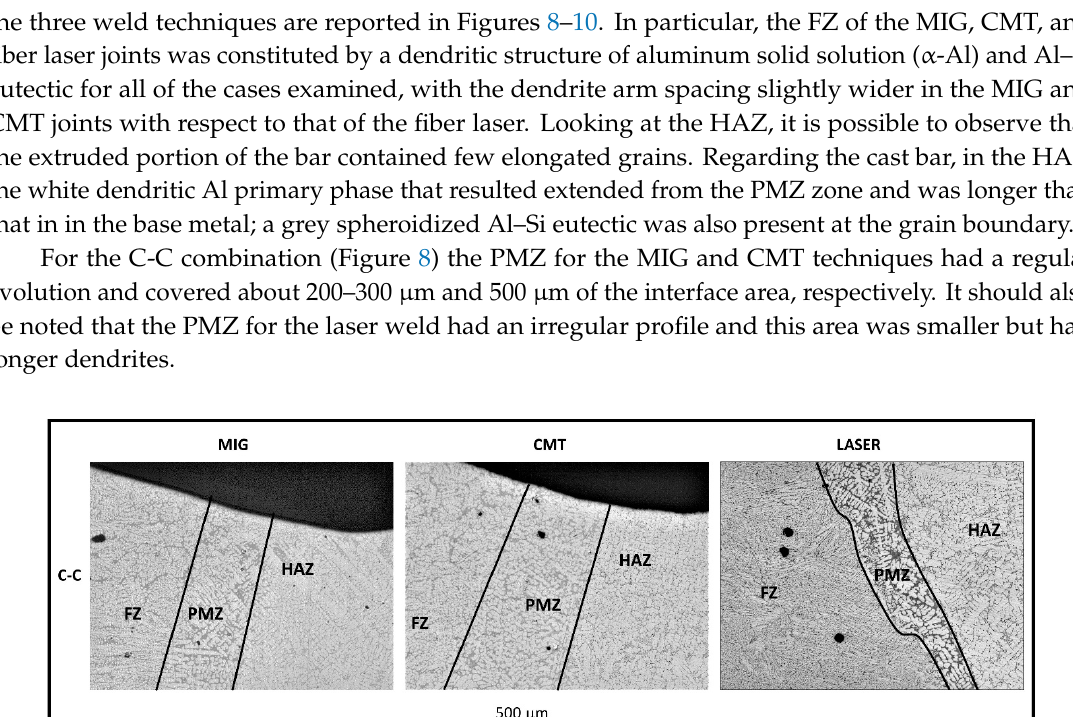
Figure 9. Macrostructures of the interface between the HAZ, PMZ, and FZ in the Extruded-Extruded (E-E) combination, Keller etch, 50×. 3.3. Hardness Distribution From the hardness evolution depending on the distance from the welding axis, it is possible to acquire information on the temperature profiles reached in the HAZ. The Al alloys, as objects of study, can be approximated to a pseudo binary Al-Mg2Si system. For this class of alloys, the hardening metastable phase is subjected to a precipitation process that is generally reported in the following steps: β ” (hardening metastable phase), β ’ (intermediate metastable phase), and β (equilibrium phase Mg 2 Si). On the basis of previous work [56,57], the maximum hardness value was reached with the metastable phase β ” having a needle-like structure. The hardness contribution of phase β ’, which had a rod morphology, was moderate, while that of the β equilibrium phase was almost negligible.